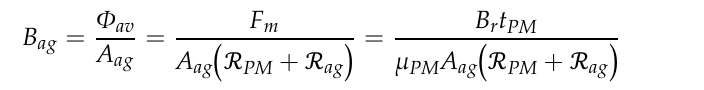
Figure 3. Lumped-circuit element based magnetic circuit model of the VCM, where 𝑡 (cid:3017)(cid:3014) , 𝑡 (cid:3028)(cid:3034) , 𝑡 (cid:3028) , and 𝑡 (cid:3052) are the thickness of the permanent magnet (PM), air-gap, armature, and yoke, respectively. 𝑙 (cid:3047) is the length from the outer face to the axis of the VCM. ℛ (cid:2913)(cid:2869) , ℛ (cid:2913)(cid:2870) , and ℛ (cid:2913)(cid:2871) are the equivalent reluctance of the stator material.